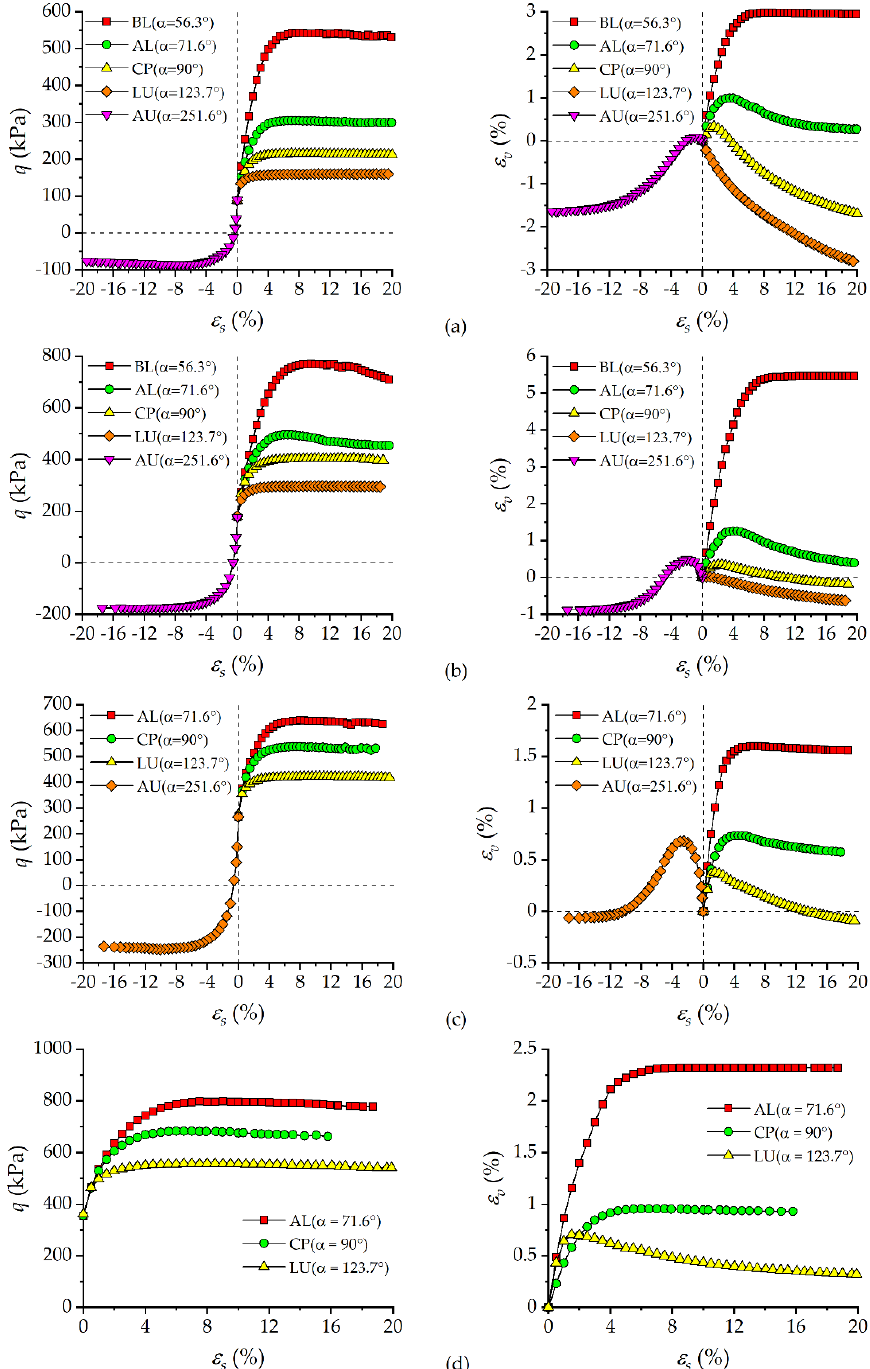
Figure 7. Stress − strain curves and volumetric strain − shear strain curves of the soil under: ( a ) σ 3 c = 100 kPa; ( b ) σ 3 c = 200 kPa; ( c ) σ 3 c = 300 kPa; ( d ) σ 3 c = 400 kPa.